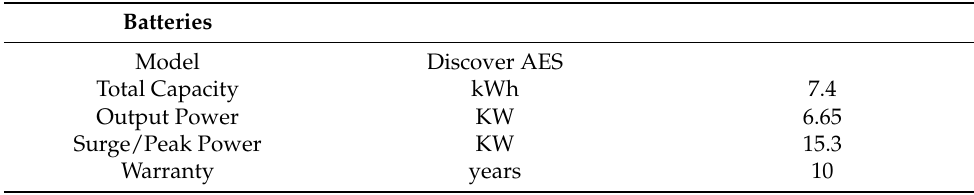
Table 9. Battery design